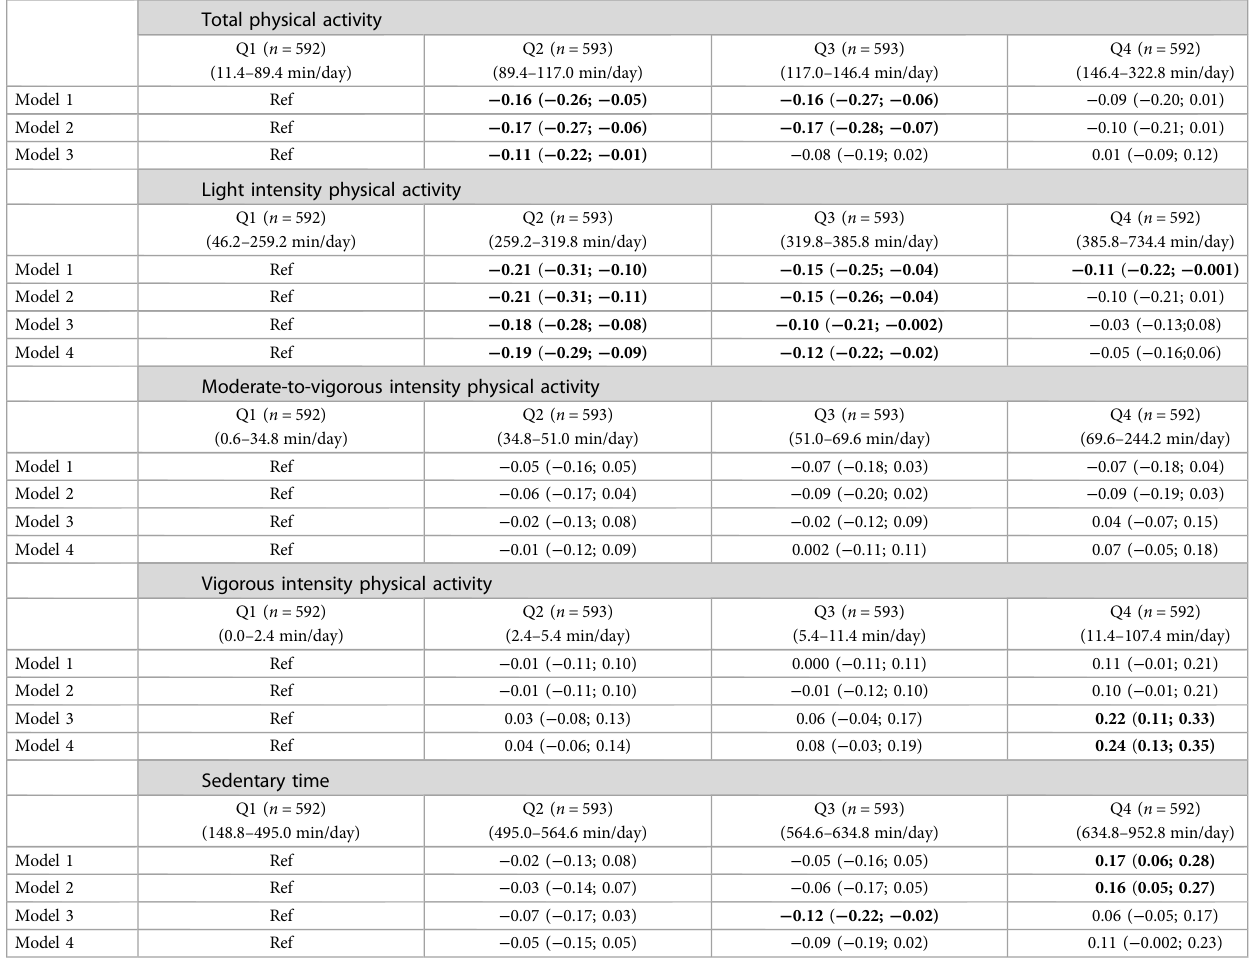
TABLE 2 Associations of physical activity and sedentary behavior with Hs-cTnI (categorical) ( n =2,370). Total physical